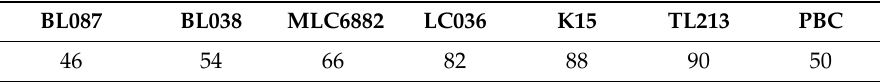
Table 3. Threshold voltage (V) obtained for each HPDLC device with different LC.